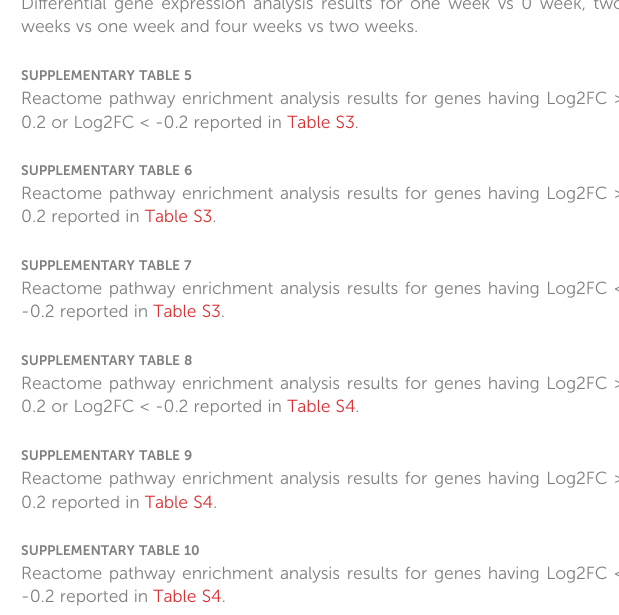
SUPPLEMENTARY TABLE 4 Differential gene expression analysis results for one week vs 0 week, two weeks vs one week and four weeks vs two